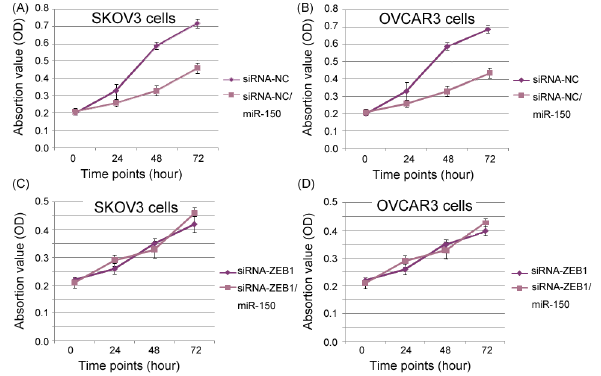
Figure 5. MicroRNA-150 (miR-150) inhibits cell proliferation of epithelial ovarian cancer (EOC) cells in vitro by targeting Zinc Finger E-Box Binding Homeobox 1 (ZEB1). (A and B) Growth curves of SKOV3 and OVCAR3 cells transfected with siRNA-NC, and SKOV3 and OVCAR3 cells transfected with siRNA-NC and miR-150 vector. (C and D) Growth curves of SKOV3 and OVCAR3 cells transfected with siRNA-ZEB1, and SKOV3 and OVCAR3 cells transfected with siRNA- ZEB1 and miR-150 vector.